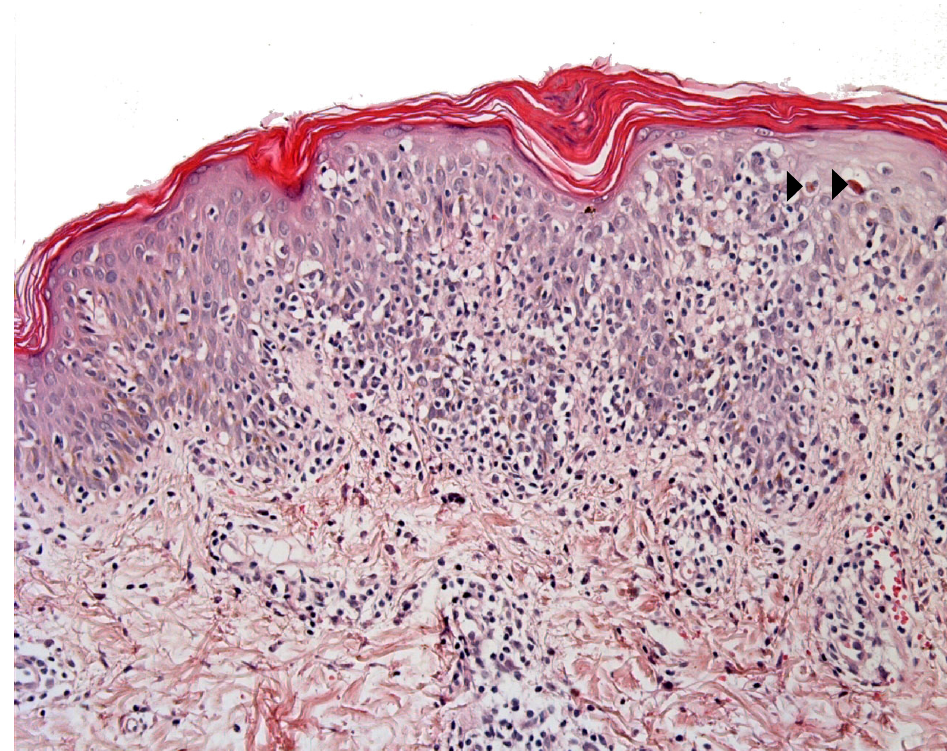
Figure 3. Mycosis fungoides-like pityriasis lichenoides. In this example there is a marked lymphocytic exocytosis, with lymphocytes displaying a clear halo. Note the few necrotic keratinocytes (arrowhead). HE ×250.